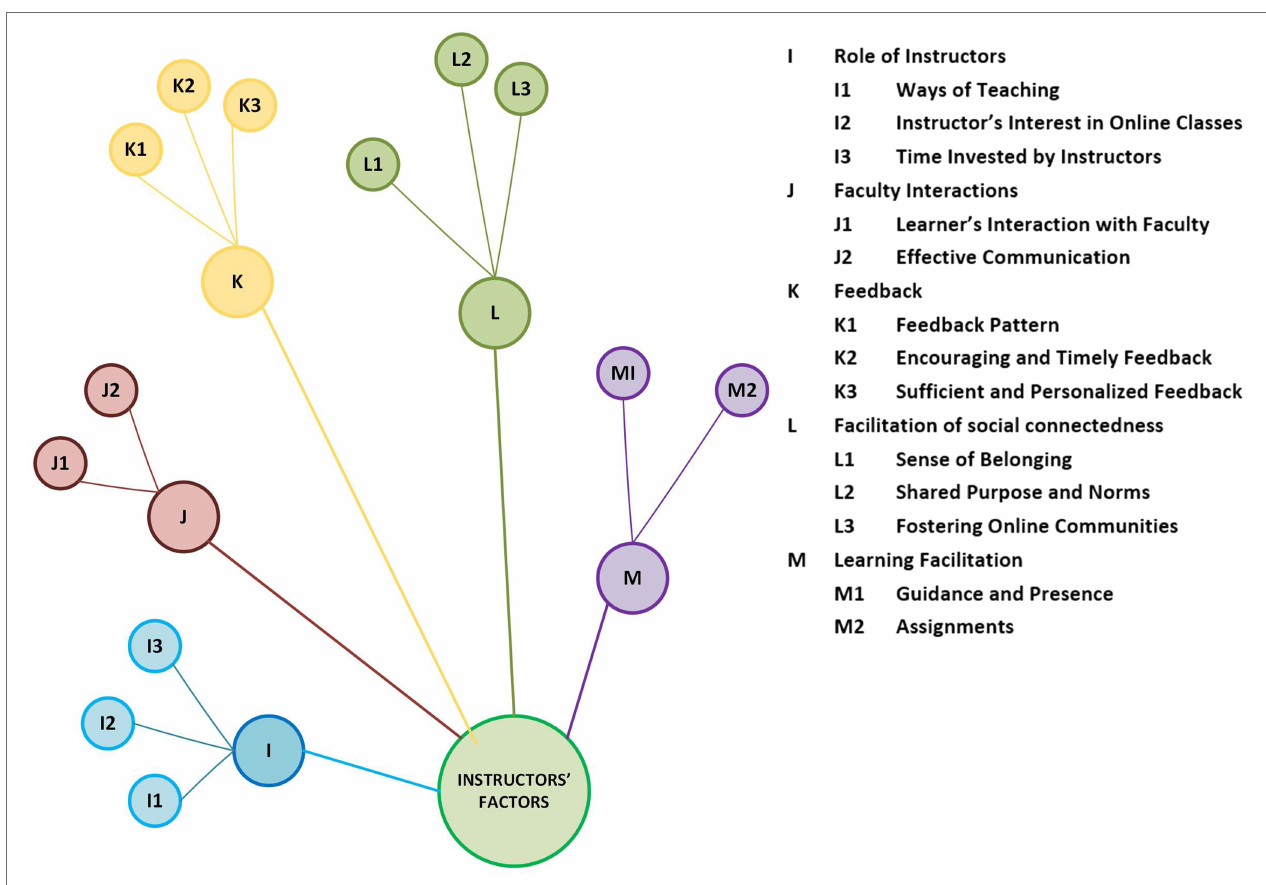
FIGURE 5 | Categorical arrangement of factors related to online course